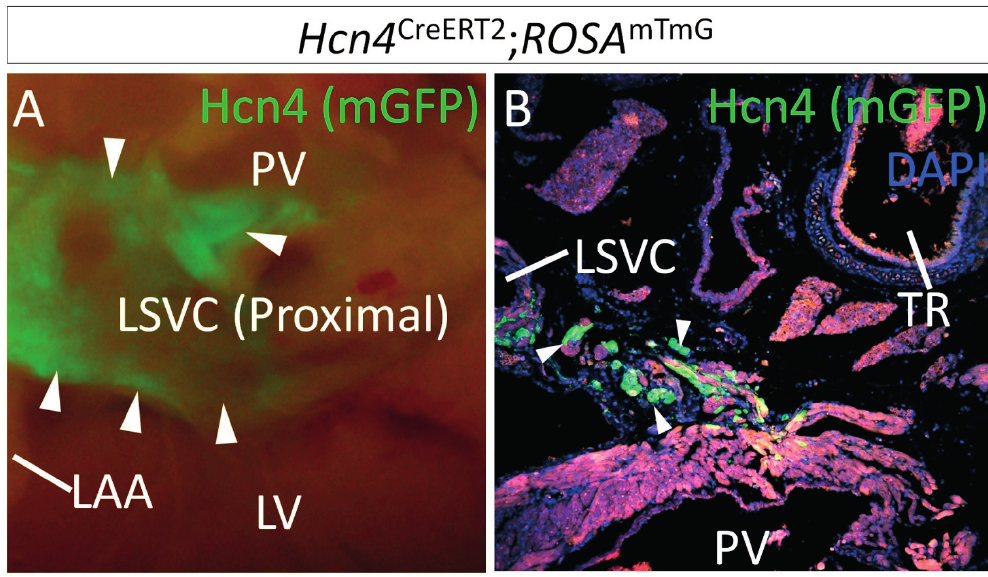
Figure 2. Hcn4 expression in the proximal junction of the PV and LSVC myocardium of an adult mice. ( A ) Dorsal view of EGFP expression (arrowheads) in an adult Hcn4 CreERT2 ; ROSA mTmG mouse seven days after tamoxifen induction. ( B ) Hcn4 positive cells (arrowheads) in the junction between the PV and LSVC of the same mouse. LV, left ventricle; PV, pulmonary vein; TR, Trachea; LAA, left atrial appendage; LSVC, left superior vena